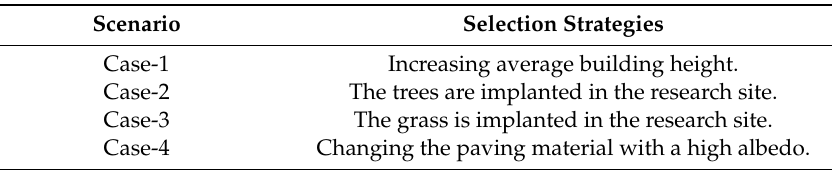
Table 7. The tested scenarios with new strategies.